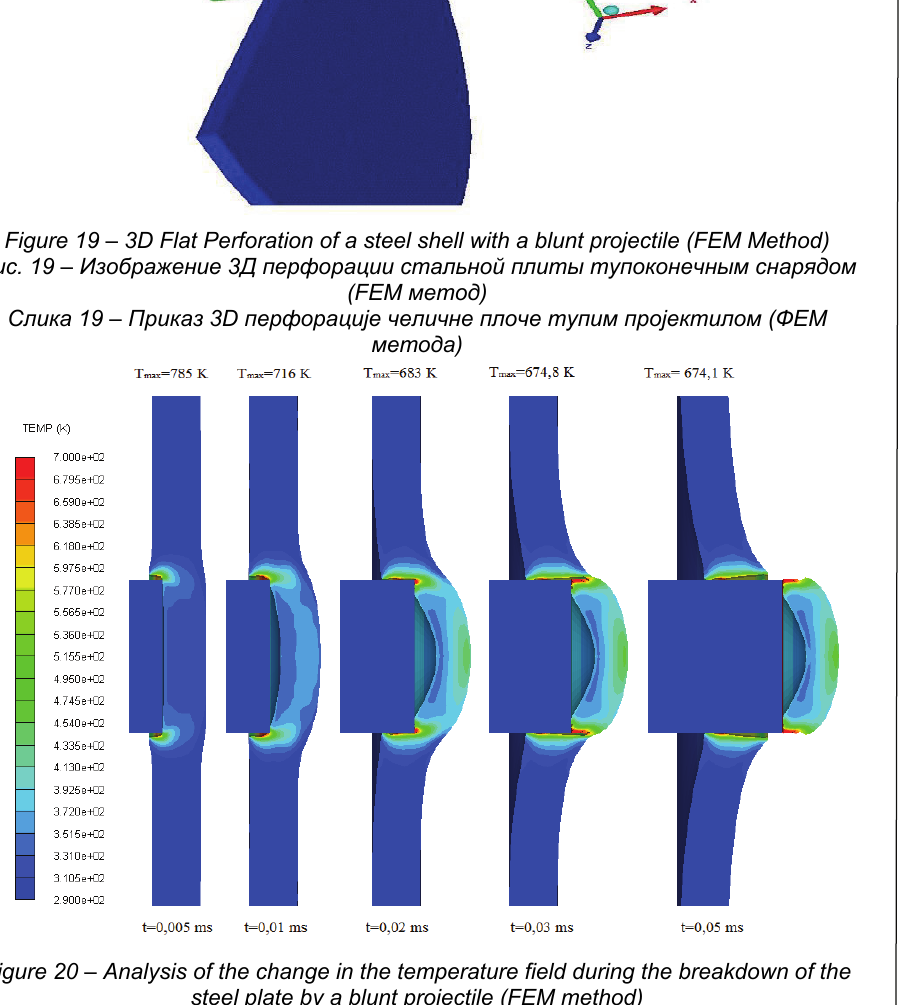
Figure 20 – Analysis of the change in the temperature field during the breakdown of the steel plate by a blunt projectile (FEM